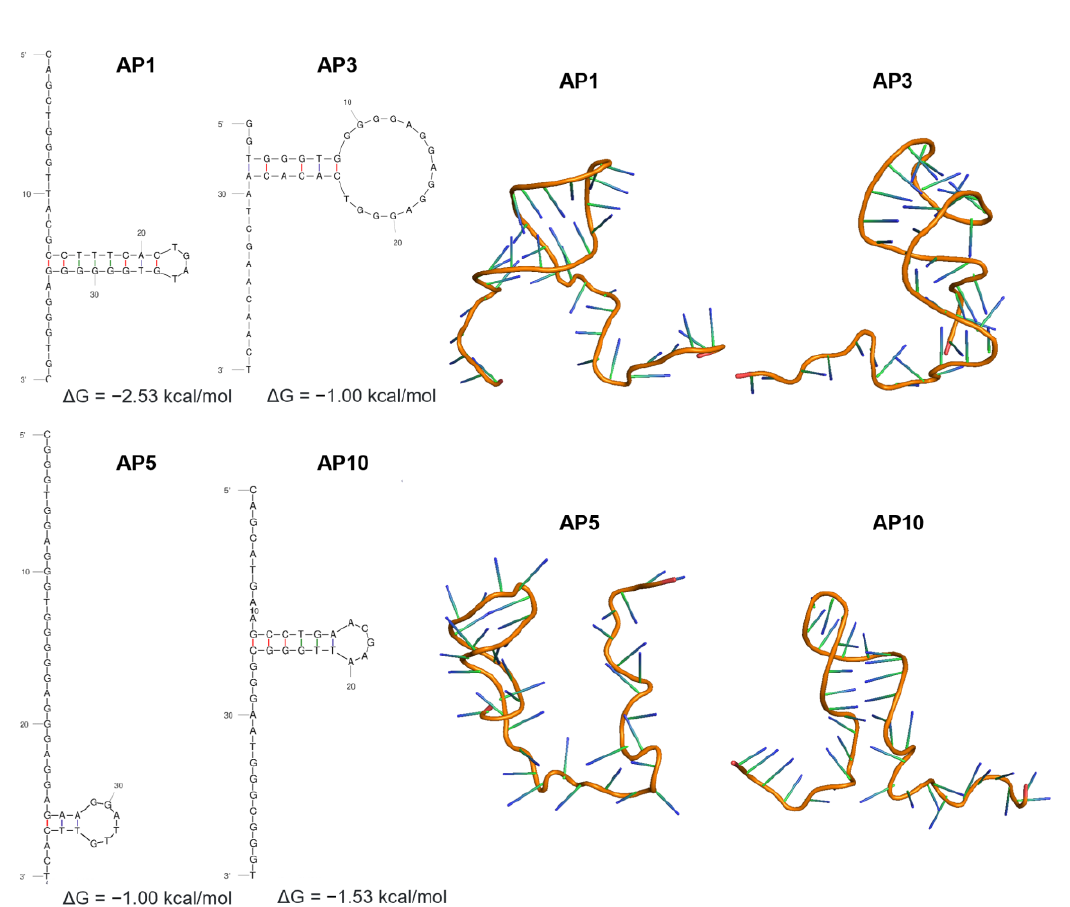
Figure 2. Secondary and tertiary structures of 40 mer aptamer sequences (AP1, AP3, AP5, and AP10) screened via cell-SELEX against inactivated Leptospira cells. The most thermodynamically stable structures (lowest free Gibbs energy) predicted using the MFold program were selected.